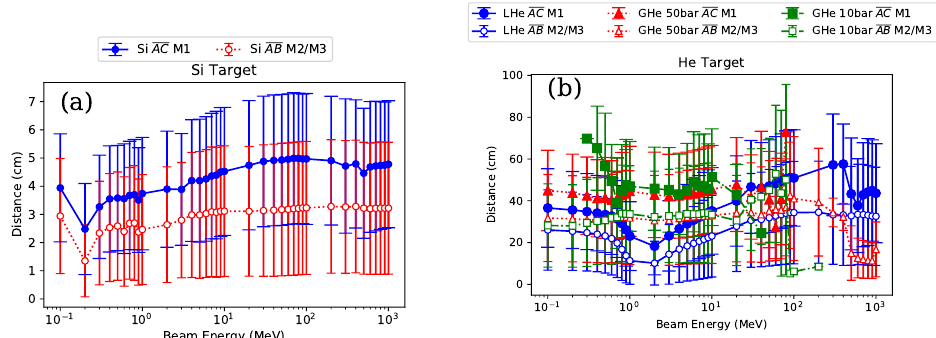
Figure 5. The mean of the distance of AC (solid line) for the M1 and AB (dashed line) for the M2. ( a ) In a 10 cm 3 Si cube, blue curve shows the case for the M1. Red curve shows the case for the M2. ( b ) In a 1 m 3 He cube, blue curve shows the case for the liquid helium, red curve shows the case for the gas helium of 50 bar, and green curve shows the case for the gas helium of 10